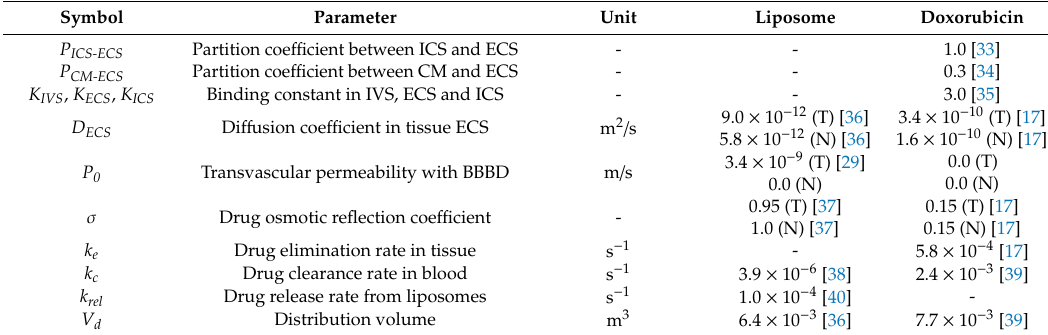
Table 1. Parameters for chemotherapeutic drugs *.